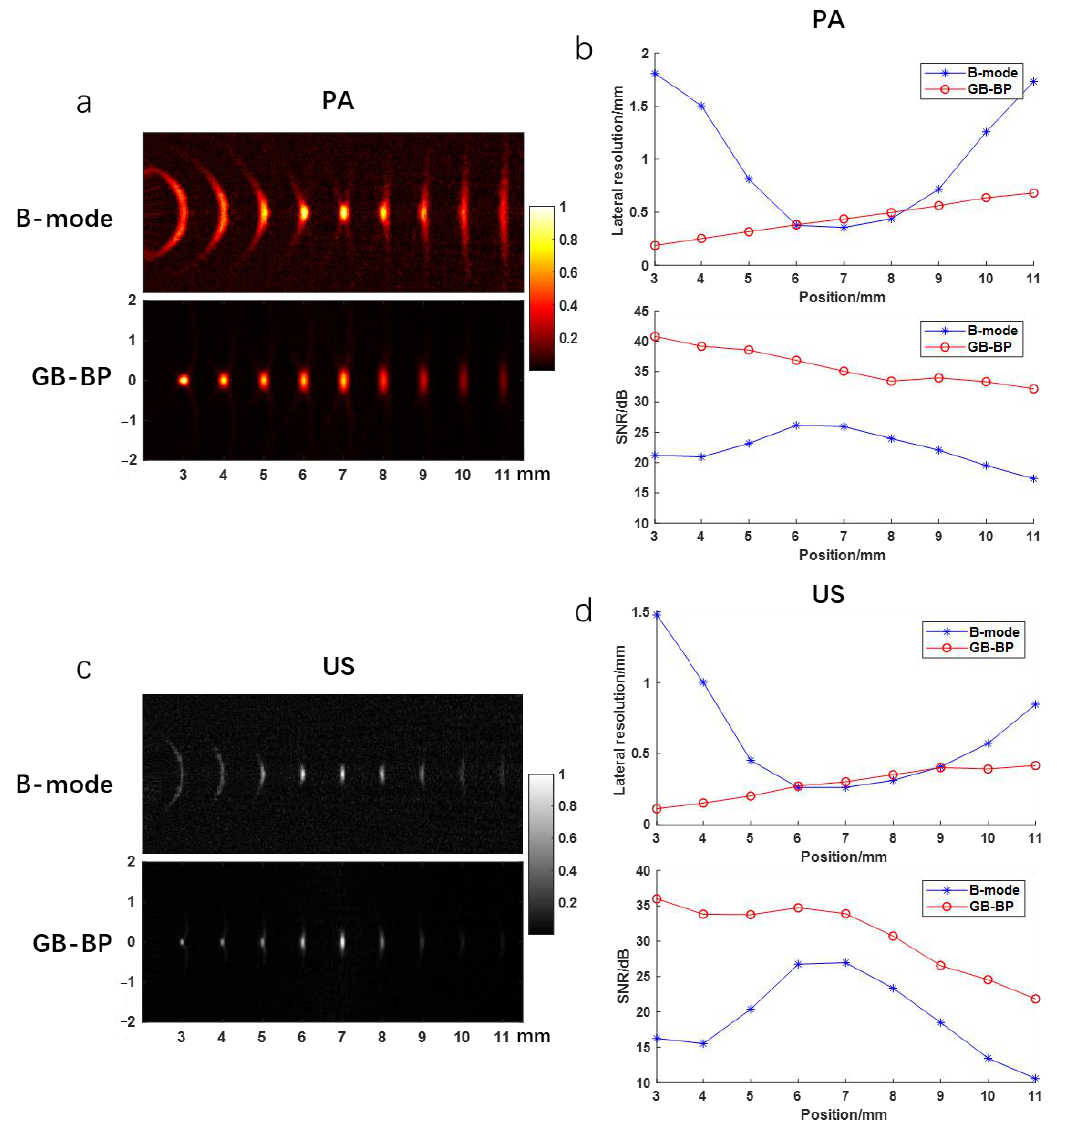
Figure 4. ( a ) The photoacoustic images reconstructed by the B-mode method and GB-BP algorithm; ( b ) The lateral resolution and SNR of the photoacoustic results in ( a ); ( c ) The ultrasonic images reconstructed by the B-mode method and GB-BP algorithm; ( d ) The lateral resolution and SNR of the ultrasonic results in ( c ). Coordinate axis units are millimeters.